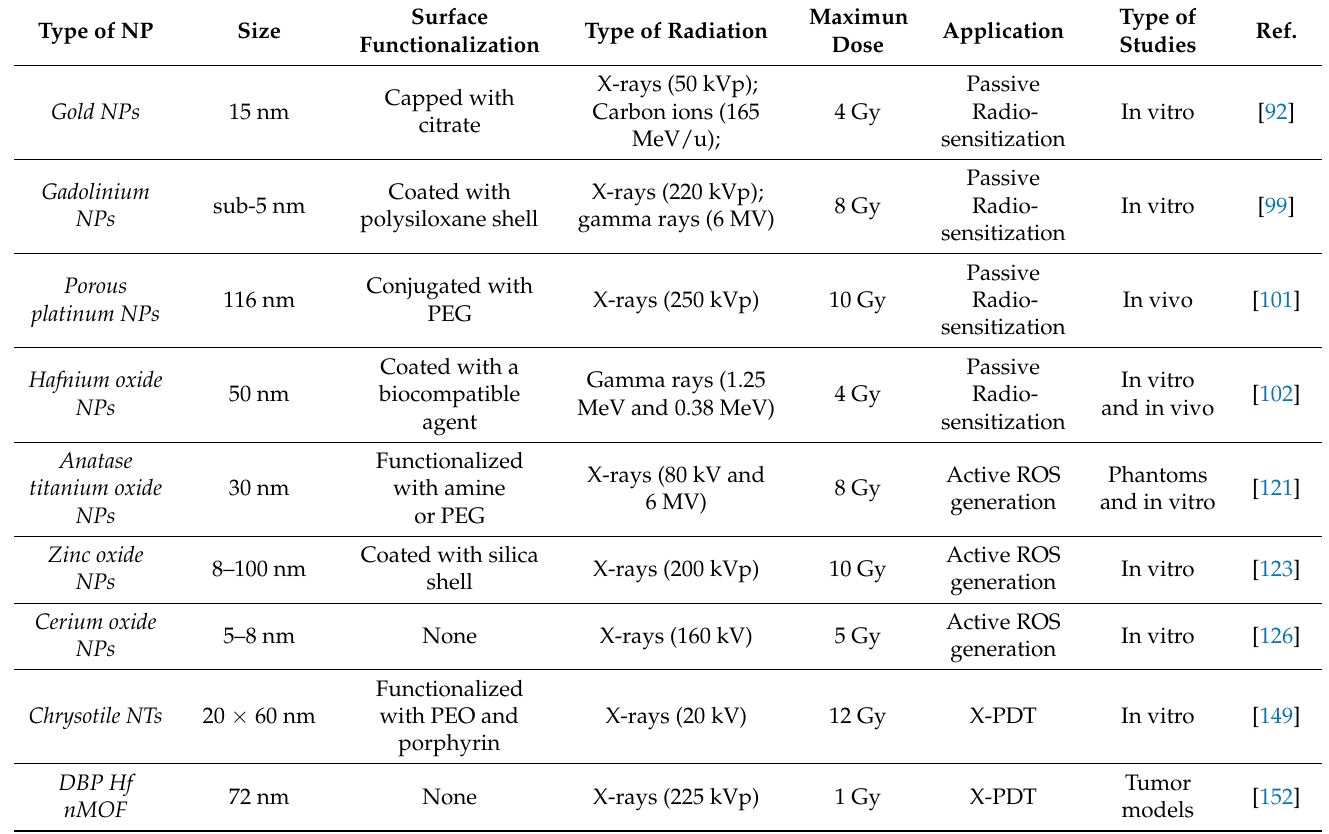
Table 1. Table summarizing the properties of the diverse nanoparticles, explored in the manuscript, together with the proposed application and the expected effects in RT, the type of radiations (with the final delivered dose), and the stage of the investigation (in vitro or in vivo